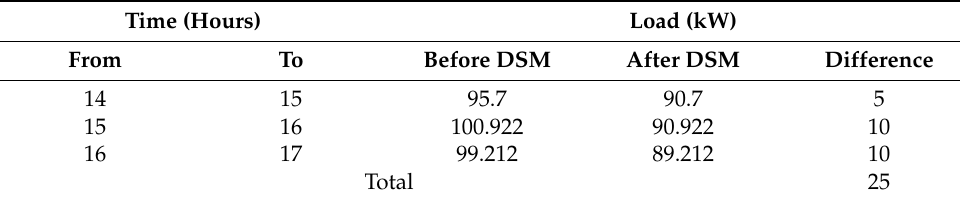
− 25 Figure 5. Load shifting in daily load profile. 3.2. Determination of Monthly Peak Load—HOMER Tool The HOMER tools can perform a renewable hybrid system analysis based on various sensitive parameters such as technical, economic, and environmental and hybrid system costs. It determines the peak load for a month based on the scaled annual average method. HOMER computes the peak load, saving energy using Equations (5) and (6)—National Renewable Energy Laboratory (NREL) [52]. It calculates the load factor through average load and peak load value.